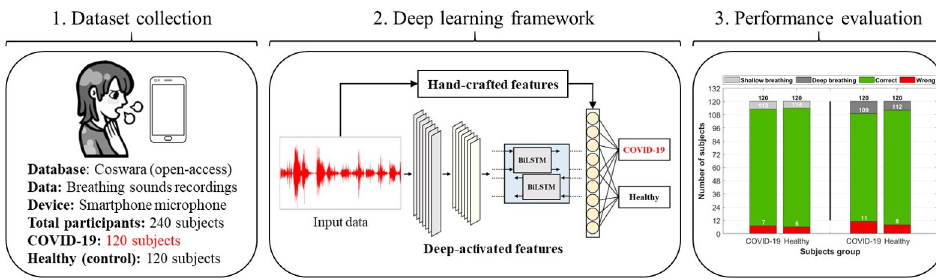
Fig 1. A graphical abstract of the complete procedure followed in this study. The input data includes breathing sounds collected from an open-access database for respiratory sounds (Coswara [41]) recorded via smartphone microphone. The data includes a total of 240 participants, out of which 120 subjects were suffering from COVID-19, while the remaining 120 were healthy (control group). A deep learning framework was then utilized based on hand- crafted features extracted by feature engineering techniques, as well as deep-activated features extracted by a combination of convolutional and recurrent neural network. The performance was then evaluated and further discussed on the use of artificial intelligence (AI) as a successful pre-screening tool for